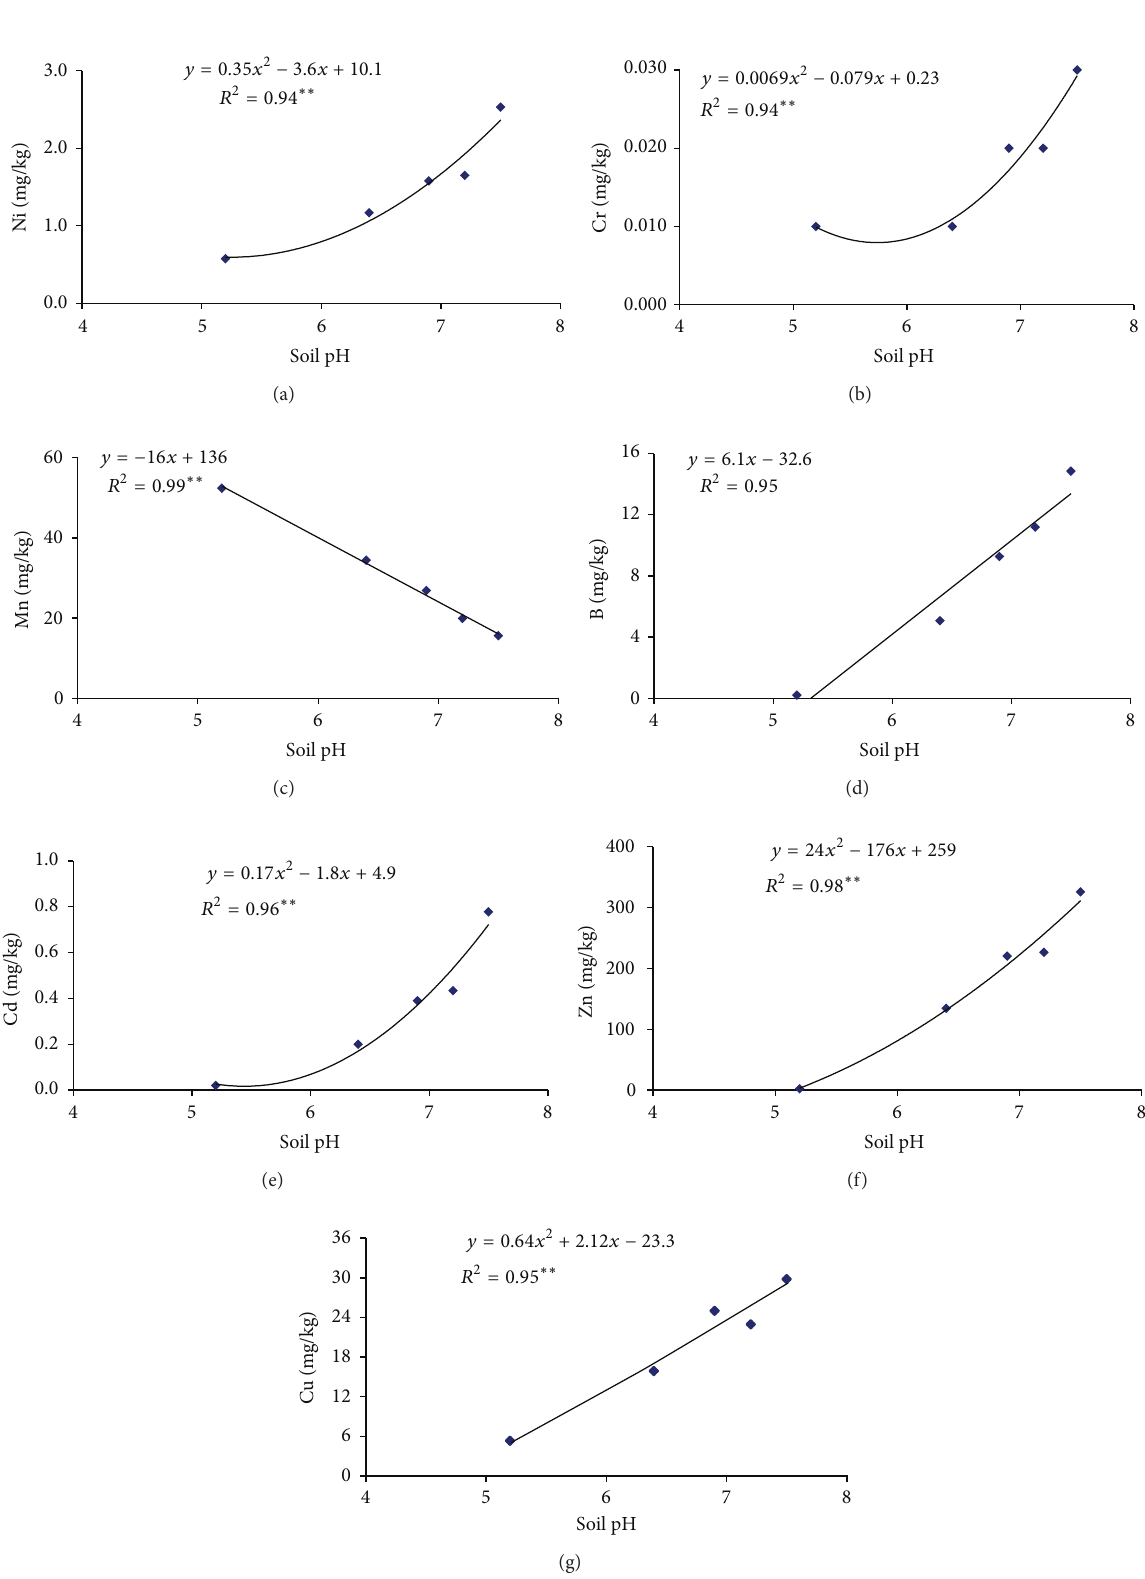
Figure 1: Effect of soil pH on the some elements availability in the soil mixtures tested. ∗∗ Significant at 𝑃 < 0.01